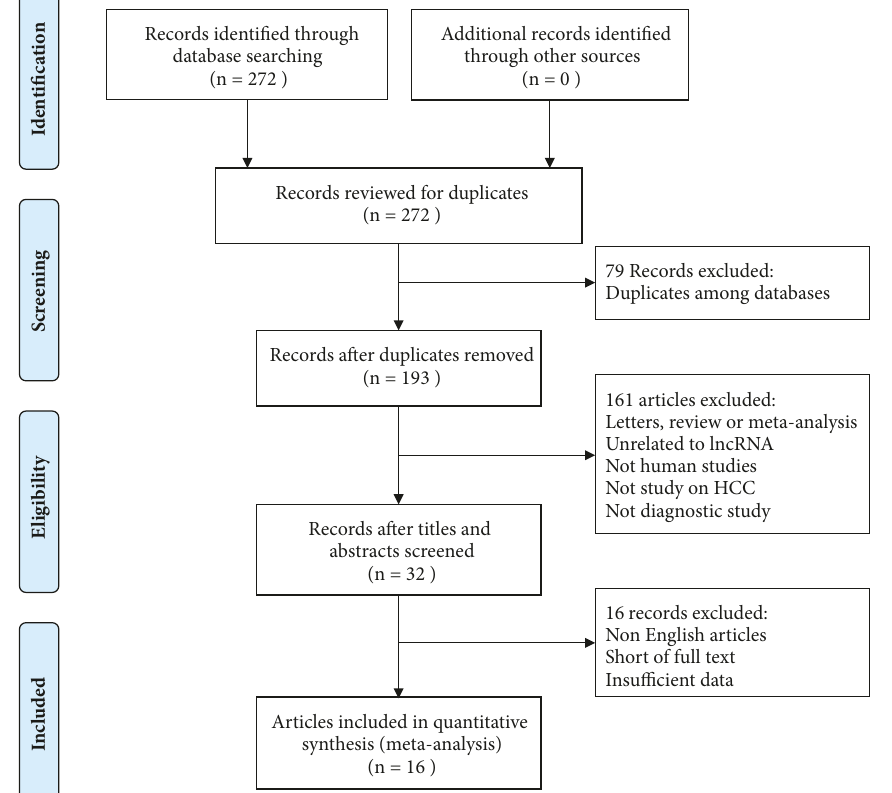
Figure 1: Selection process of articles included in the final meta-analysis.